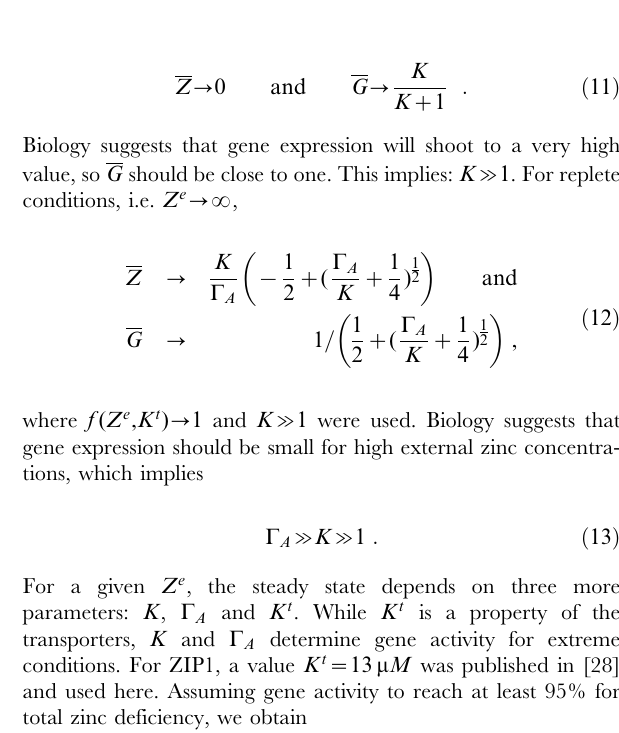
Figure 4. Plant roots: Scheme of the three models of zinc uptake regulation. A, Activator only [Eq. (9)], B, Activator with dimerization [Eq. (15)], C, Activator-Inhibitor model [Eq. (16)].